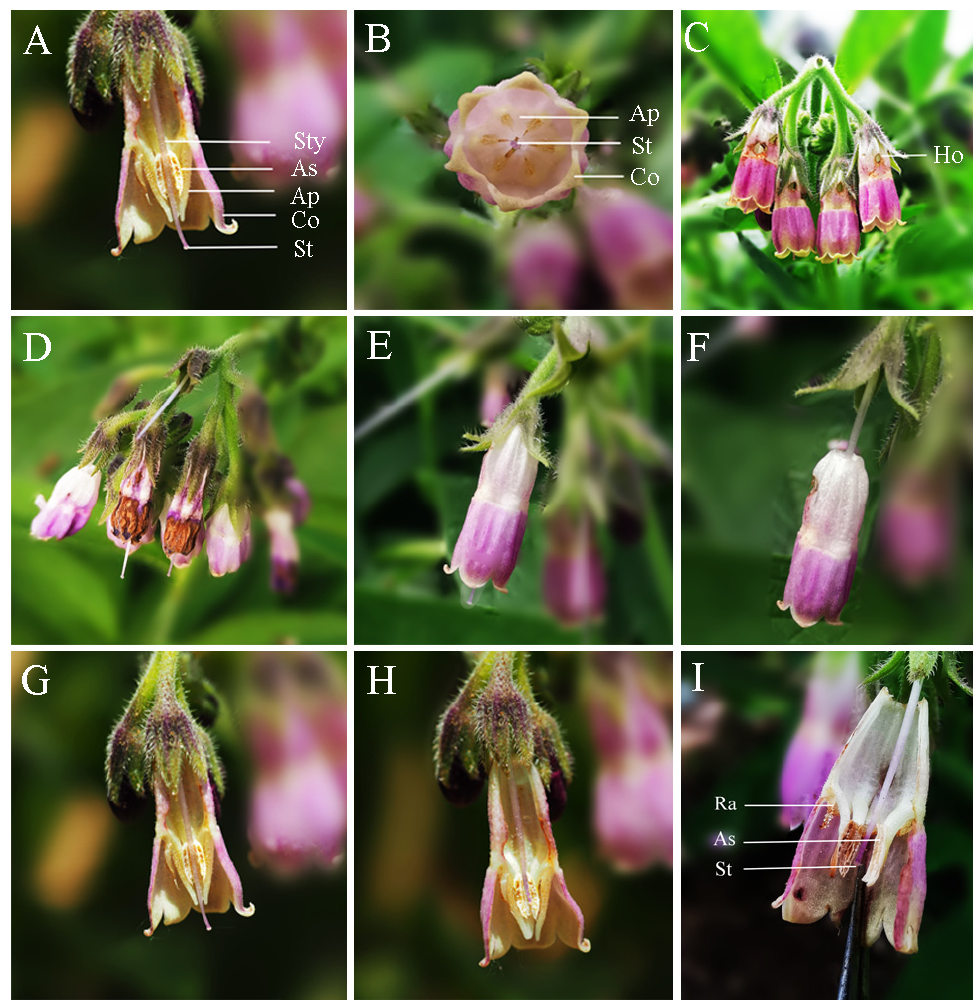
Figure 6. The floral traits and process of corolla abscission. ( A – C ) The morphological characteristics for S. officinale , comprising stamens and pistil in the opening flower. St, stigma; Co, corolla; Ap, appendages; As, anther sac; Sty, style; Ho, holes made by nectar robbers. ( D ) The wilted flower in the insect-excluding bags. ( E , F ) Corolla abscission and slipping along the style. ( G , H ) Anther movement and the process of self-pollination upon corolla abscission. ( I ) The process of corolla abscission after removal of appendages: Ra, residues of appendages; As, anther sac; St, style. S. officinale flowers continuously secreted nectar until corolla abscission, and flowers accumulated approximately 15.1% (4.89 ± 0.25 μ L) of total nectar volume before opening (45.71 ± 5.22 μ L). Flowers accumulated a nectar volume similar to that secreted before the